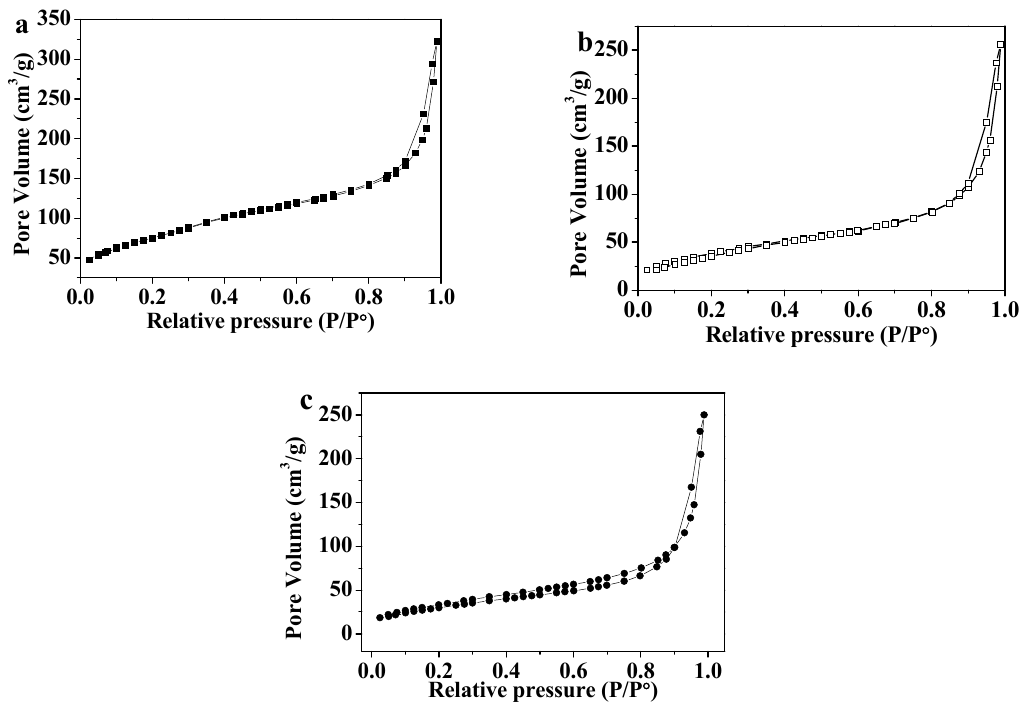
Figure 4. The N 2 adsorption and desorption curves of ( a ) MSN, ( b ) MSN-PEI, and ( c ) MSN-PEI-FA. Table 1. The corresponding parameters of N 2 adsorption and desorption.